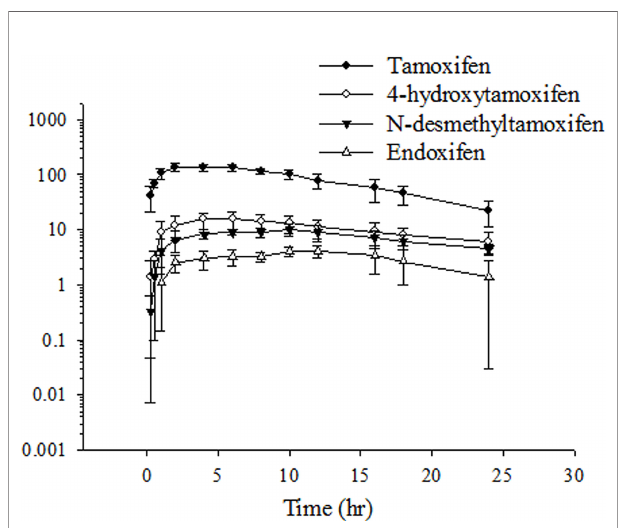
FIGURE 1 | Time – concentration curve of tamoxifen, 4-hydroxytamoxifen, N - desmethyltamoxifen, and endoxifen in rat plasma after oral tamoxifen administration (10 mg/kg). Data are expressed as the mean ± standard deviation ( n = 6 per group).